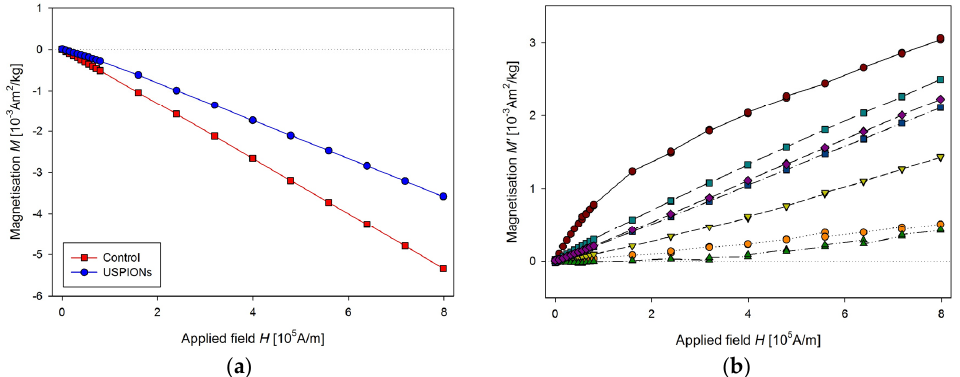
Figure 11. Magnetic properties of the liver of control and USPION-treated rats. ( a ) The partial M ( H ) dependences at 300 K. Data are presented as the averaged curve from the control group ( n = 11) and USPION-treated group ( n = 9). The mass of dry samples was in the range of 12–30 mg. ( b ) Corresponding M ’ data for individual rats of the USPION-treated group after subtraction of the control group average. The same procedure of the measurement as for the liver was used for the samples from left heart ventricle (Figure 12) and kidney (Figure 13). In the case of kidney, the smaller cutting tool was used, with a diameter of 3.5 mm.